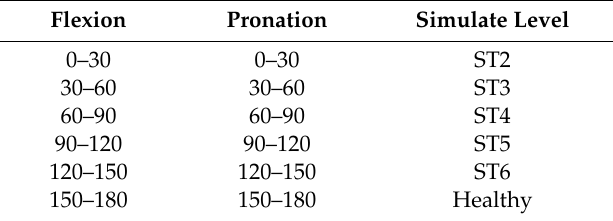
Table 2. Definition of Brunnstrom Stages.